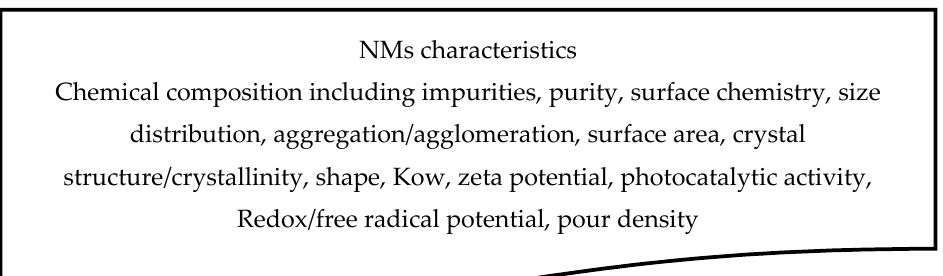
Figure 3. The NMs’ characteristics information, based on reliable measurements, is the starting point for risk assessment.